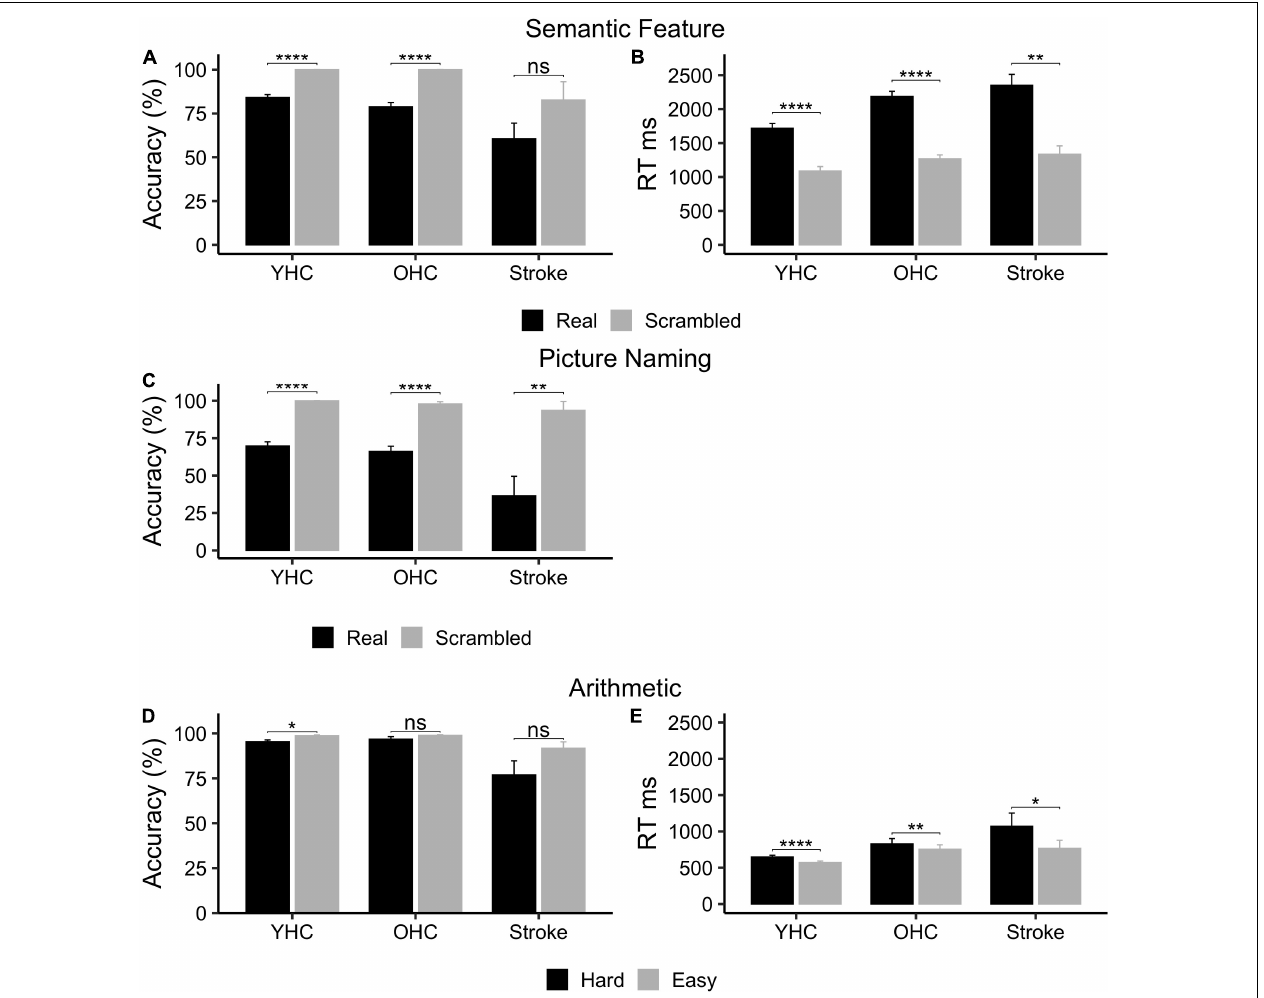
FIGURE 3 | Behavioral task performance for all three participant groups. (A) Semantic feature – accuracy. (B) Semantic feature – reaction time. (C) Picture naming – accuracy. (D) Arithmetic – accuracy. (E) Arithmetic – reaction time. ms, milliseconds; %, percent accurate. * represents significant difference between conditions at p < 0.05 level, ** represents significant difference between conditions at p < 0.01 level, and **** represents significant difference between conditions at p < 0.001